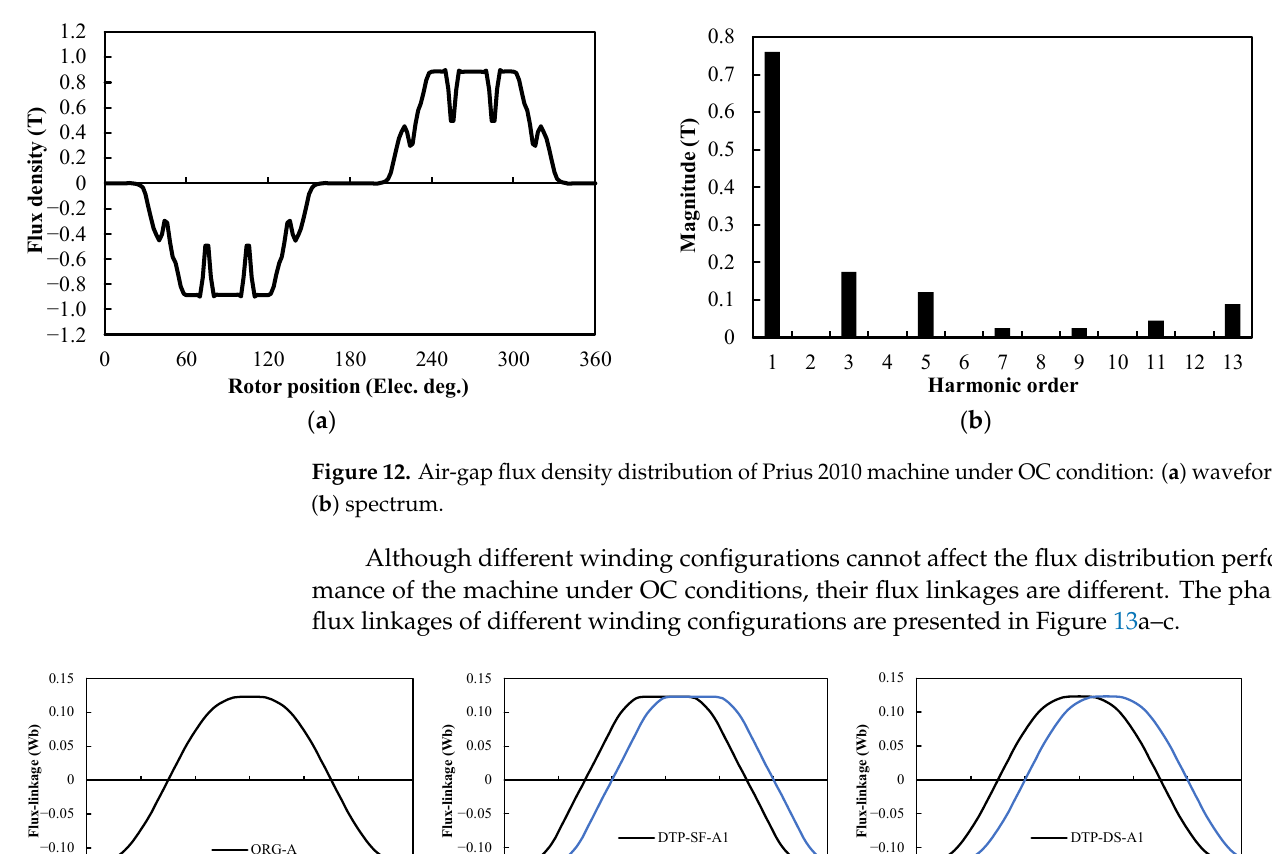
Figure 11. Flux distribution of Prius 2010 machine under OC condition: ( a ) contour; ( b ) flux line distribution.